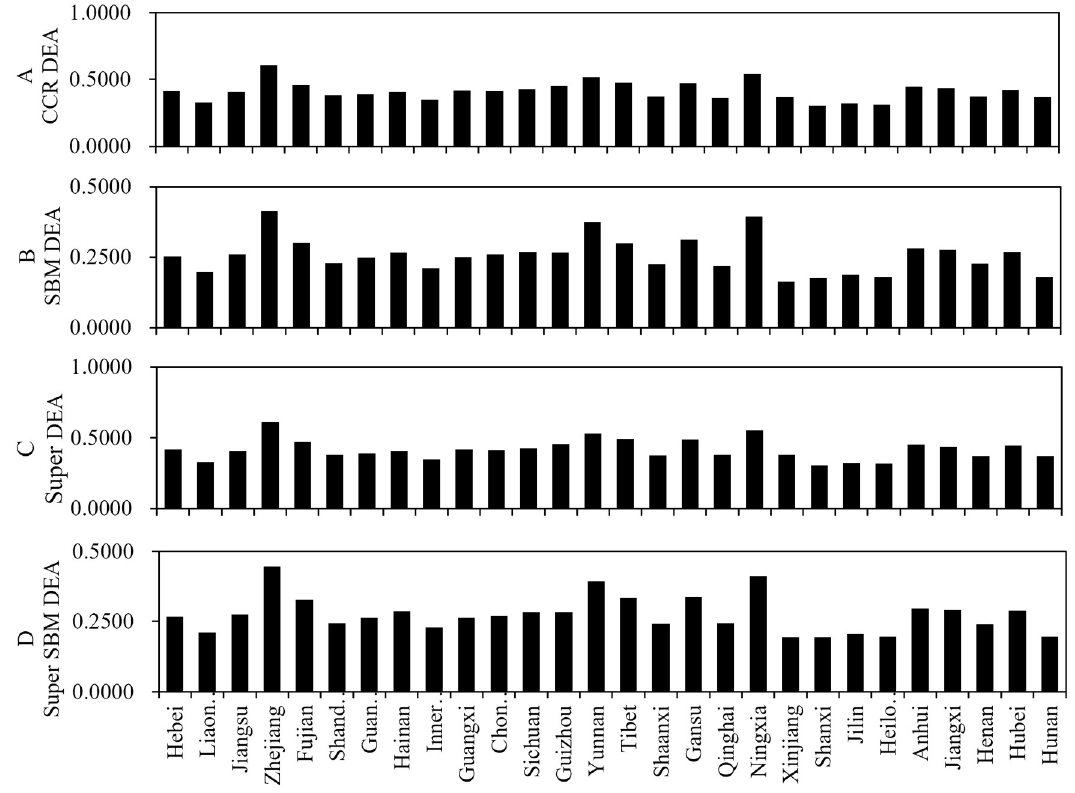
Fig 6. Provincial mean value of hospital efficiency of different DEA models by CCR, SBM, super and super SBM DEA model.